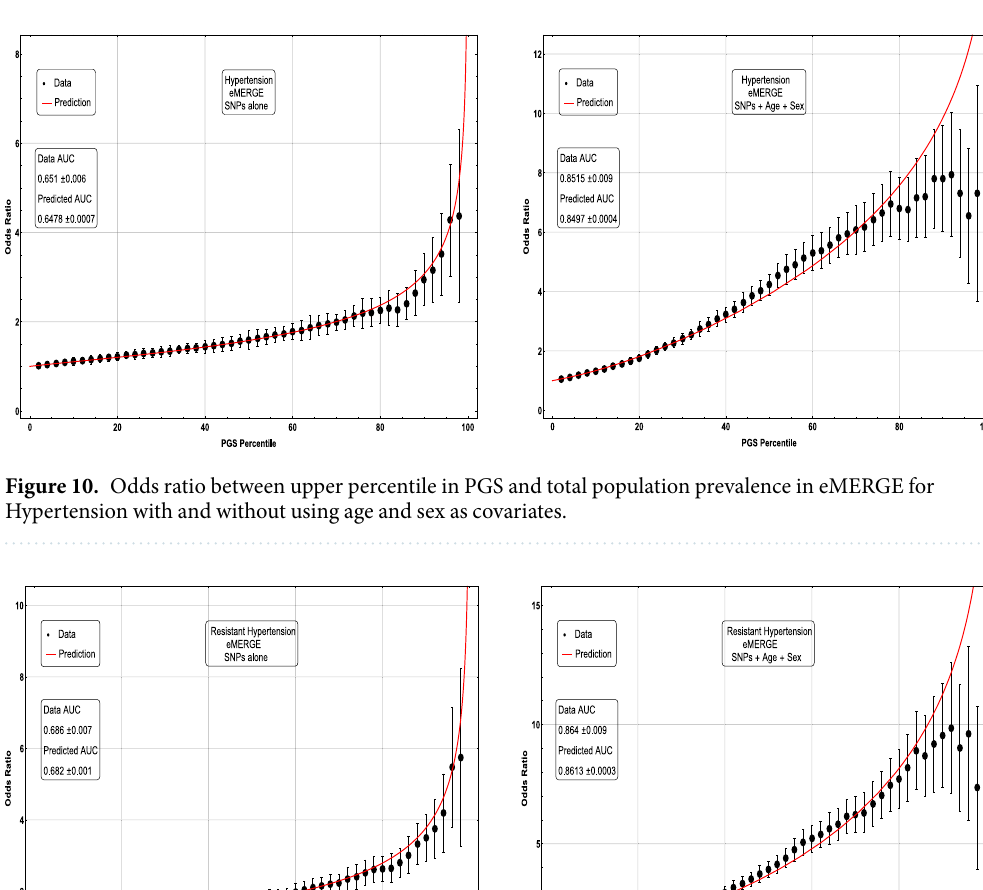
Figure 9. Odds ratio between upper percentile in PGS and total population prevalence in eMERGE for Hypothyroidism with and without using age and sex as covariates.